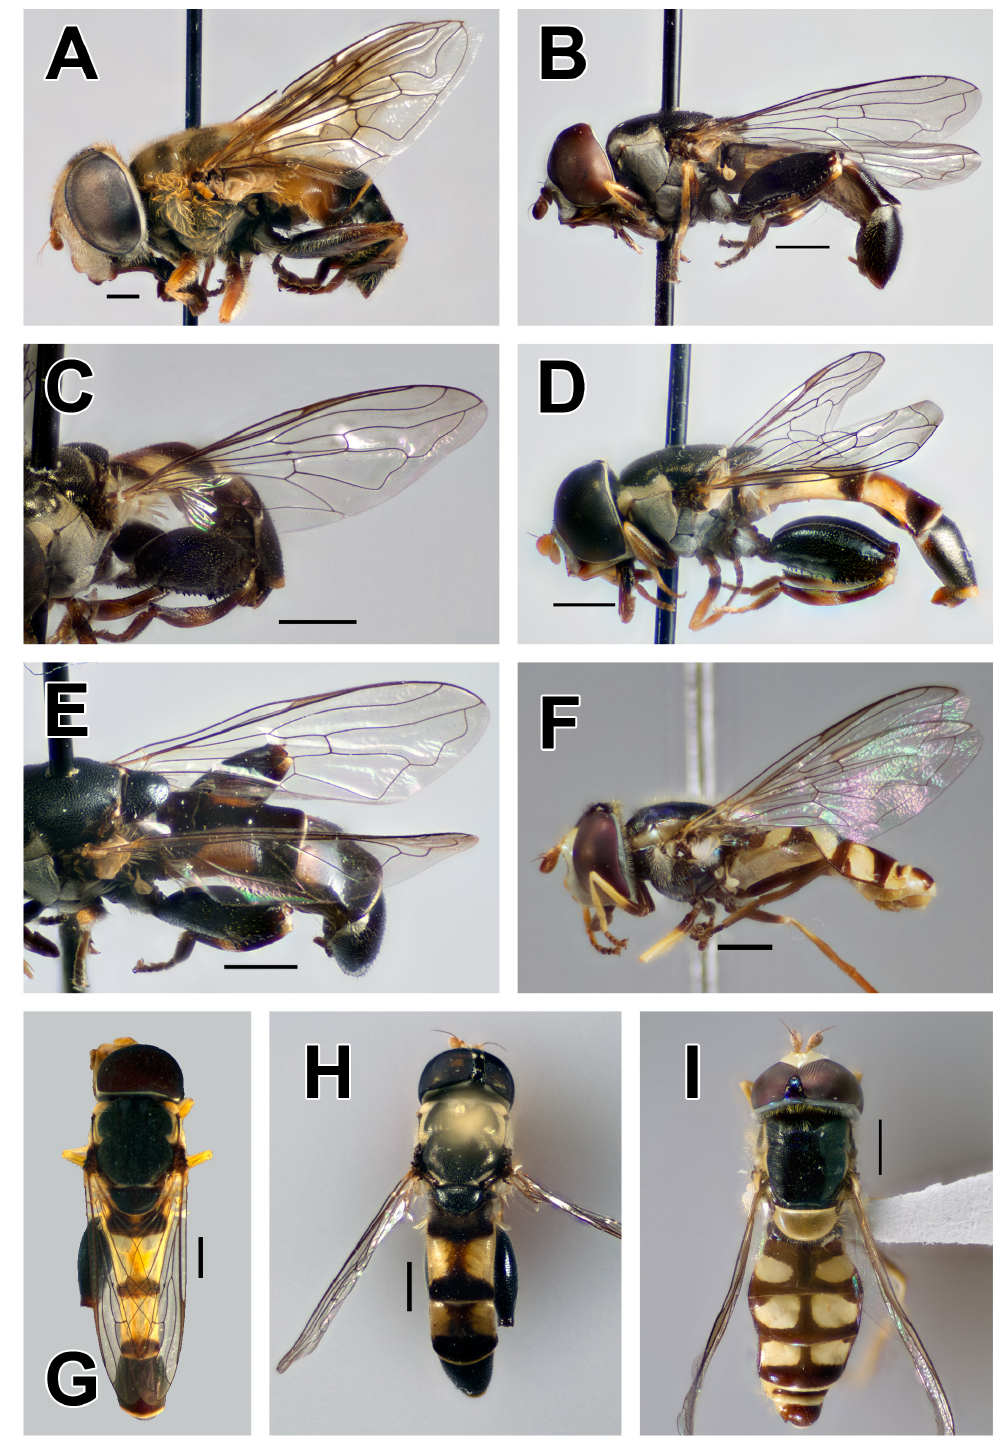
Fig. 5. A . Palpada vinetorum (Fabricius, 1798), ♀ (ZFMK-DIP-00019738), lateral view. B, E . Syritta oceanica (Macquart, 1855), ♀ (ZFMK-DIP-00019724). B. Lateral view. E. Detail of wing and abdomen. C–D, H . Syritta aenigmatopatria Hardy, 1964, ♀ (ZFMK-DIP-00019739). C. Wing and metaleg. D. Lateral view. H. Dorsal view. F, I . Simosyrphus grandicornis (Macquart, 1842), ♂ (ZFMK- DIP-00019736). F. Lateral view. I. Dorsal view. G . Syritta aenigmatopatria Hardy, 1964, ♂ (ZFMK- DIP-00019746), dorsal view. Scale bars = 1